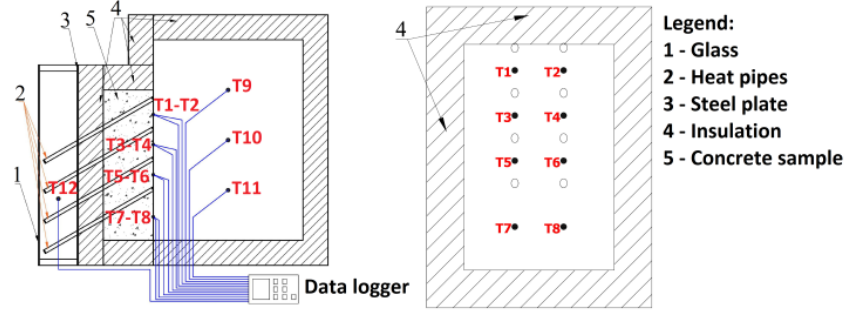
Figure 2. Experimental setup and thermocouples position.